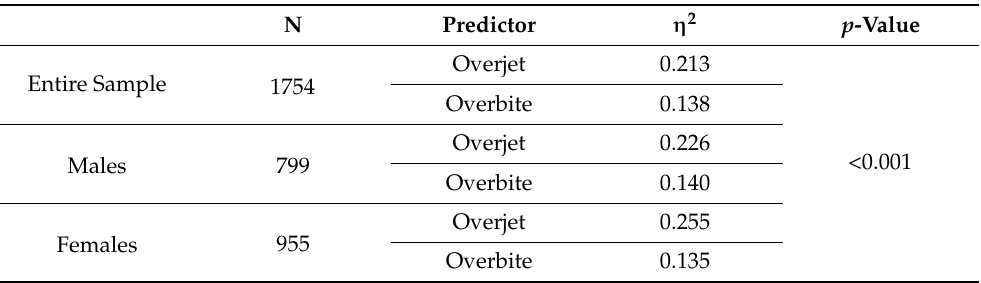
Table 1. Effect of overjet and overbite on profile shape, as explained by